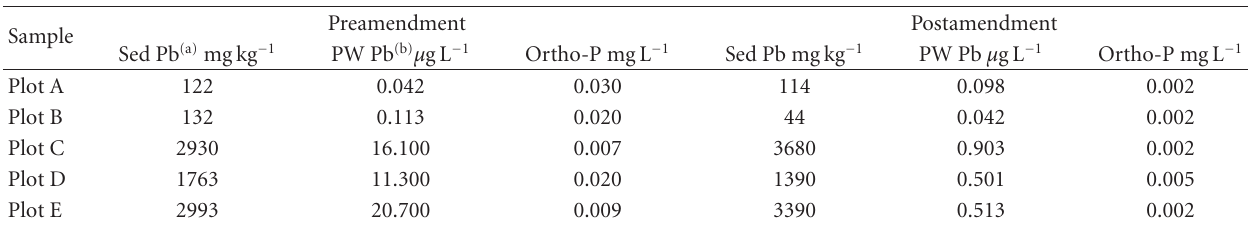
Table 2: Chopawamsic Creek sediment Pb, pore water Pb, and ortho-P concentrations for preamendment and postamendment experimental